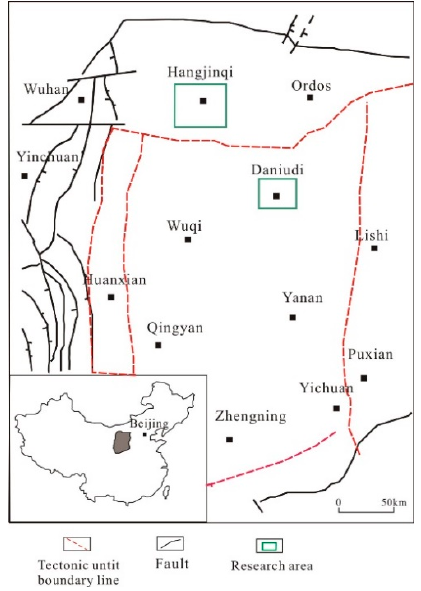
Figure 1. Locations of the study area and the studied sections.